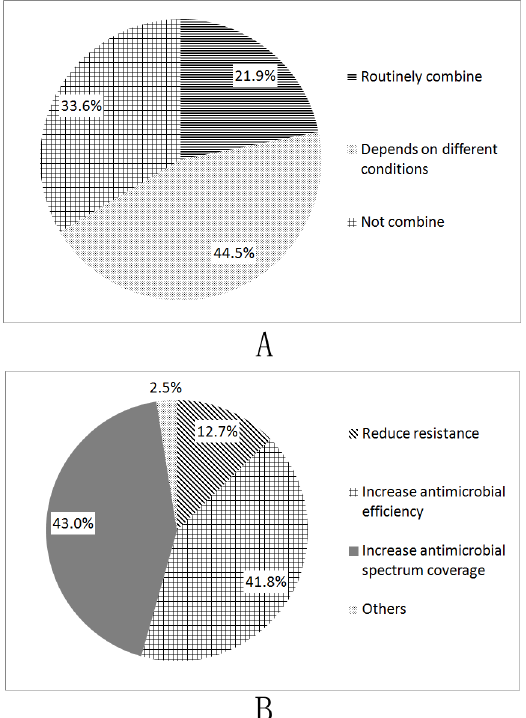
Fig 1. Response to combination of intraocular antibiotic agents. (A). Respondents using a combination of two or more antibiotic agents for intraocular administration. (B). Reasons for combination of intraocular